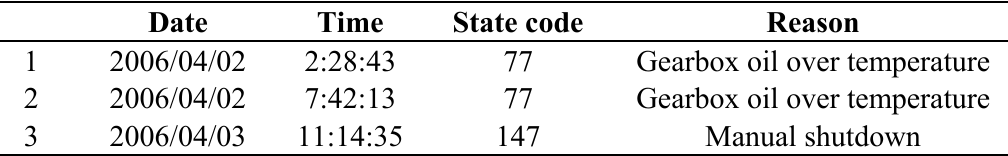
Table 1. Shutdown records from 01/04 to 06/04.